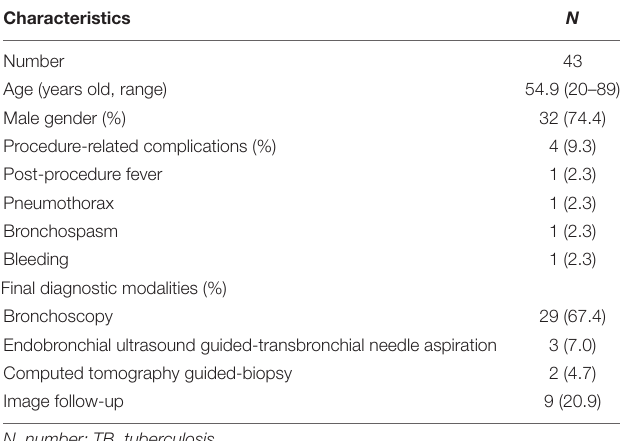
TABLE 4 | Characteristics of the 43 patients with pulmonary TB infection.